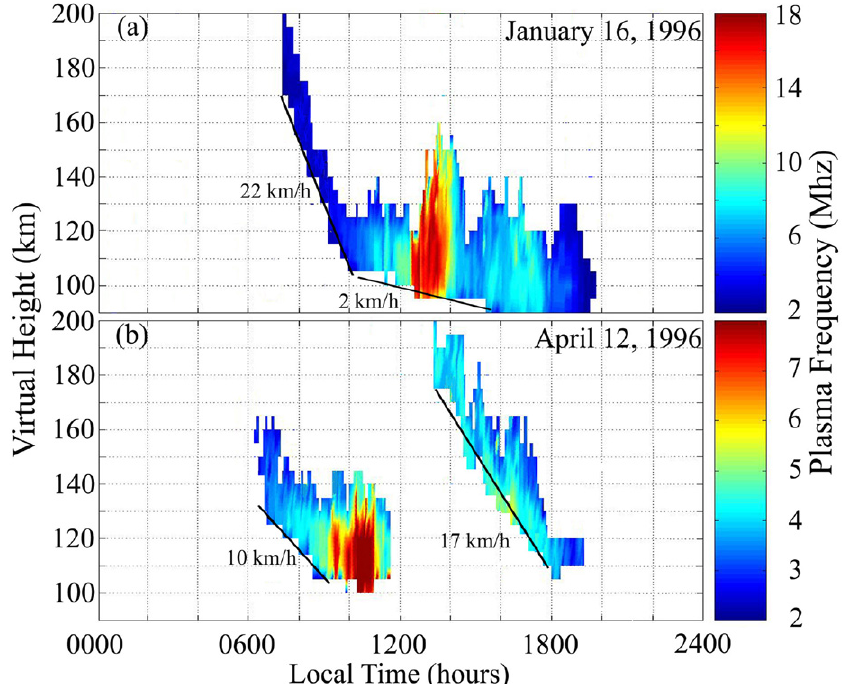
Fig. 5. Height-time-frequency (HTF) plots for 16 January (a) and 12 April (b) 1996, respectively. The horizontal axis of the HTF plot represents the local time, the vertical axis is the virtual height, and the colored level indicates the plasma frequency. This HTF plot is a new approach, which allows a digisonde to determine the variation in plasma density as an intermediate layer descends from high to low